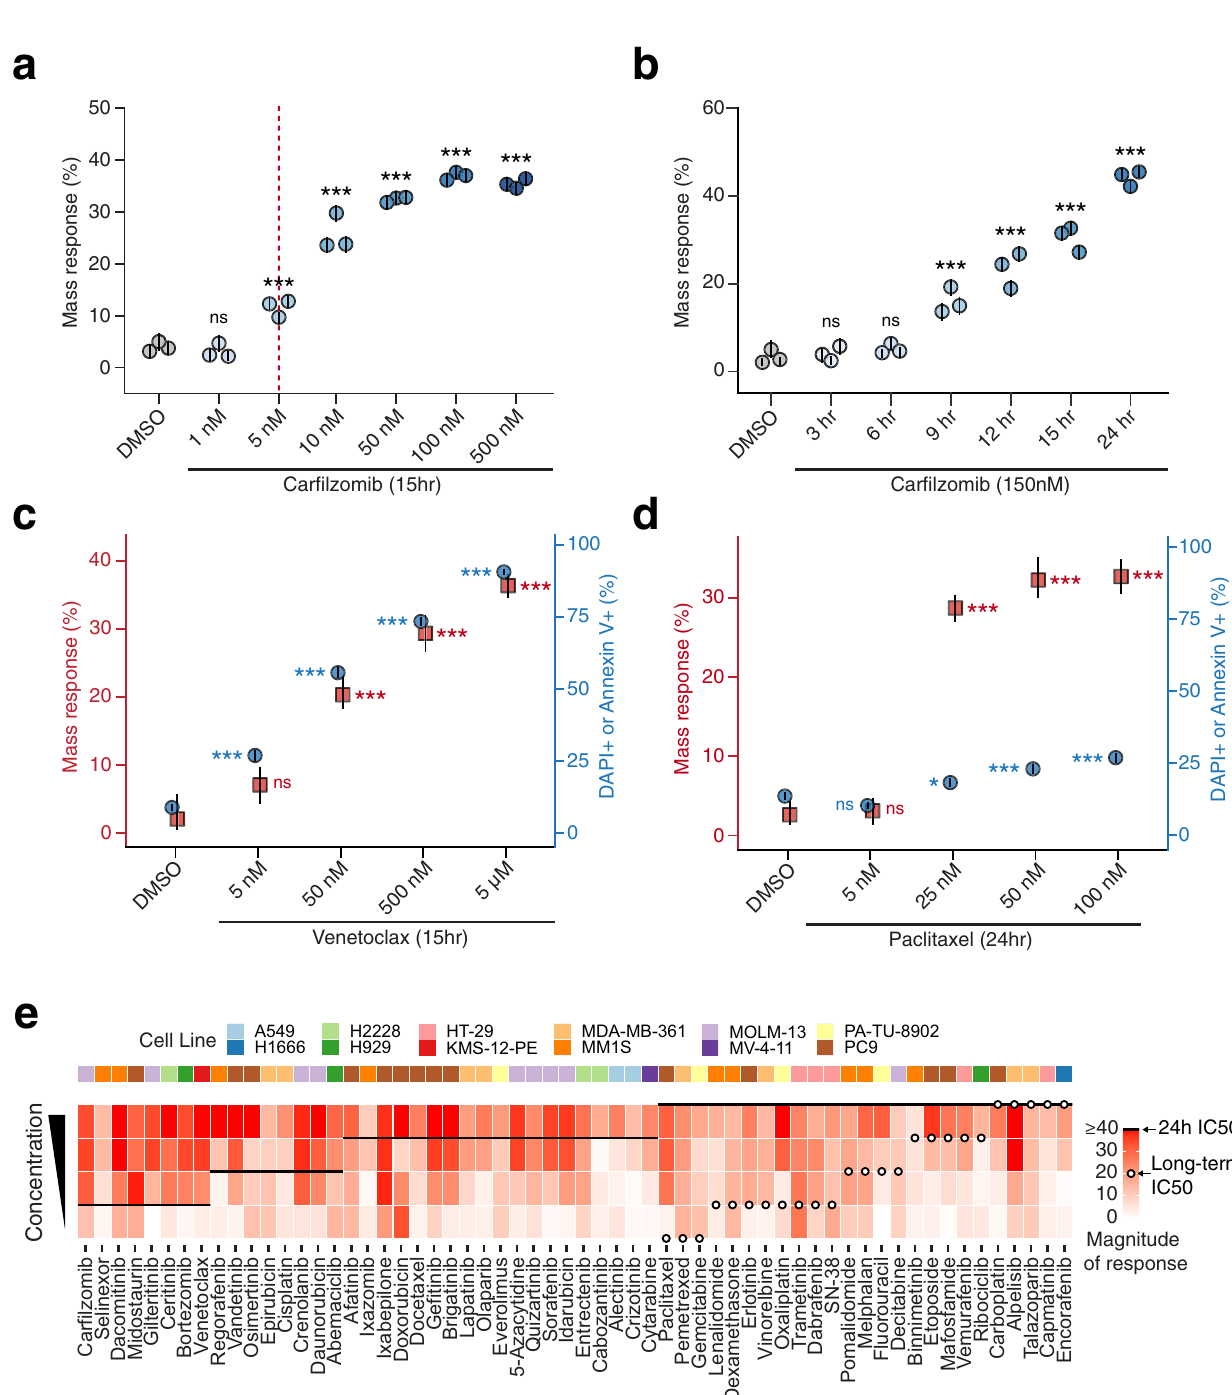
Fig. 5 Mass response changes with dose and time, and can precede cell viability loss for slow-acting drugs. Mass response signal varies with changes to dose or timing of measurement, similar to cell viability measurements. Mass response of MM1S cells treated with car fi lzomib shown when a varying dose at a 15 h timepoint or b varying timepoint with a 150 nM dose. Multiple points indicate independent instruments, overlaid lines indicate a 95% con fi dence interval for mass response de fi ned by 5000 random samples of 2500 cells. c MM1S cells treated with the fast-acting drug venetoclax for 15 h, and d PC9 cells treated with the slow-acting drug paclitaxel for 24 h, comparing dose response as measured by mass (red axis, red squares show representative mass response measurements, overlaid lines indicate 95% con fi dence interval), or fl ow cytometry-based assessment of viability using DAPI and Annexin V (blue axis, blue circles, overlaid lines indicate 95% con fi dence interval) (Methods). e Heatmap showing a mass response of cell lines (top legend) to 60 different drugs, comparing the magnitude of response (red gradient; as determined by the difference between control and the test conditions) for rank-ordered doses to 24 h IC 50 (black lines) or long-term IC 50 values (open circles). Long-term IC 50 values are only provided for drugs where 24 h IC 50 is in fi nite or greater than the highest useable concentration for testing. Drugs are ordered in the x-axis with respect to their 24 h IC 50 values. Observable mass response at doses below short and long-term IC 50 measurements for a given cell/drug combination indicate that mass changes either correspond to or precede viability loss for all drugs presented. *** indicates p < 0.001, ns indicates p >